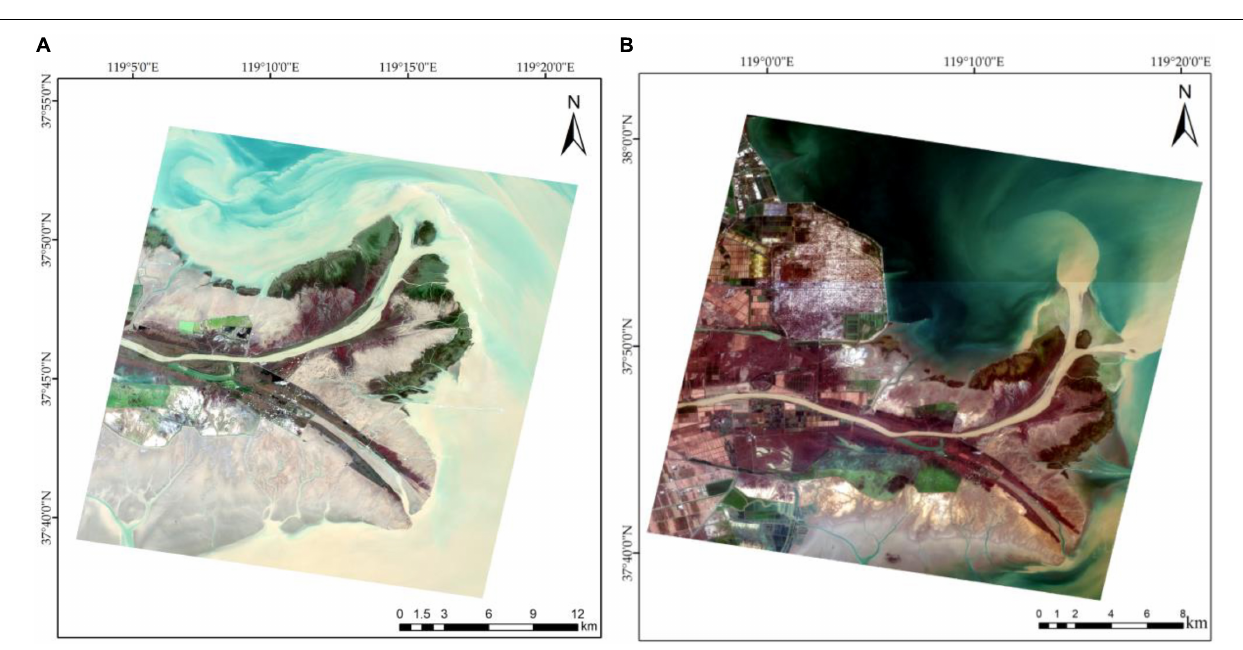
FIGURE 3 | Sentinel-2A color synthesis result. The yellow ribbon-like object in the figure is the Yellow River, and the P. australis is beside it. The light blue in the upper right is sea water. (A) Image obtained on October 12, 2017; (B) Image obtained on November 05,